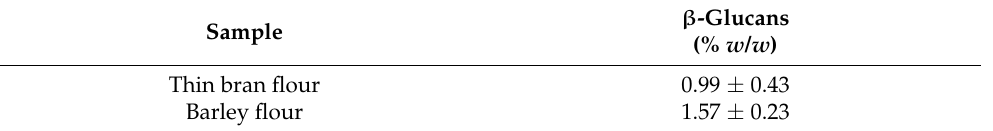
Table 11. β -Glucans contents (% w/w ) of the enriched breads, based on the raw materials (thin bran and barley flour), as determined by the two-factor ANOVA (analysis of variance).